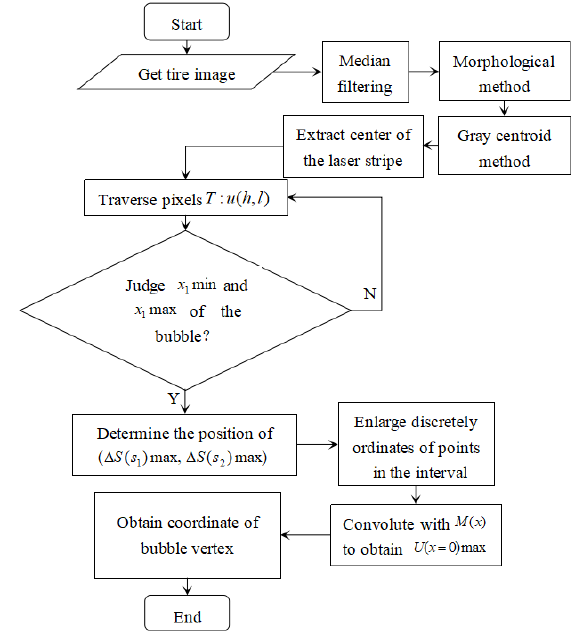
Figure 9. Flow chart of bubble defect detection.